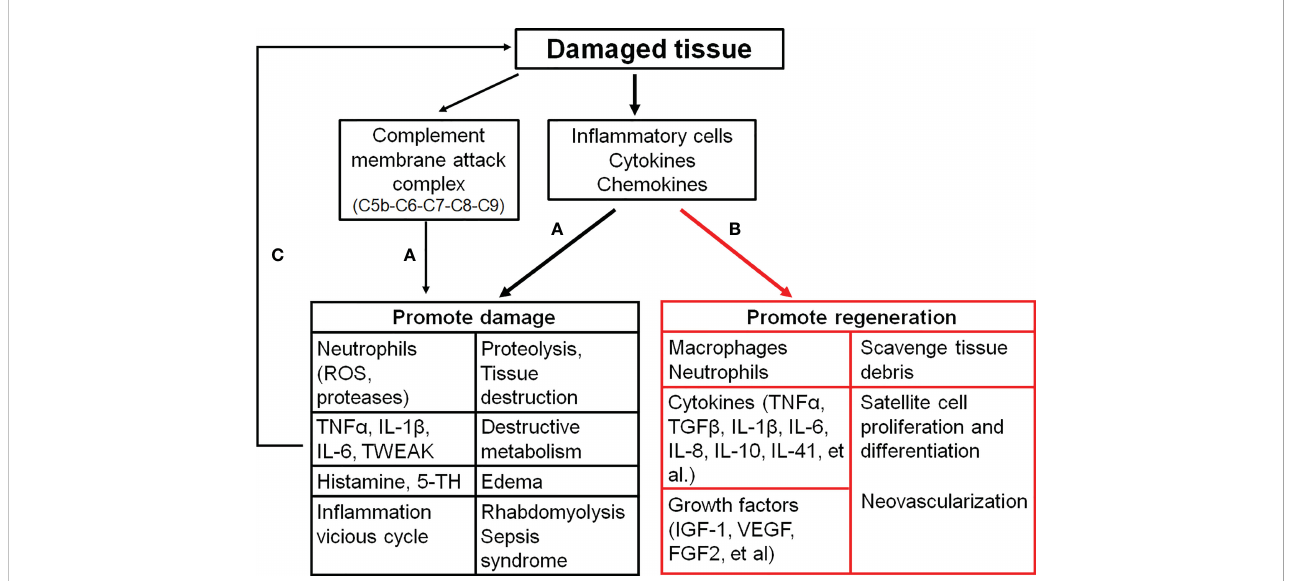
FIGURE 2 The effects of in fl ammatory activation on the skeletal muscle. (A) , in fl ammation distorys tissues; (B) , in fl ammation promtes muscle repair; (C) , a vicious cyle of the tissue damage and in fl ammation. C5b (6, 7, 8, 9), complement component 5b (6, 7, 8, 9); FGF2, Fibroblast growth factor 2; IGF-1, Insulin-like growth factor 1; IL-1 b (6, 8, 10, 41), interleukin-1 b (6, 8, 10, 41); ROS, Reactive oxygen species; TGF b , Tranformaing growth factor- b ; 5-TH, Serotonin; TNF a , Tumor necrosis factor a ; TWEAK, TNF-like weak inducer of apoptosis; VEGF, Vascular endothelial growth